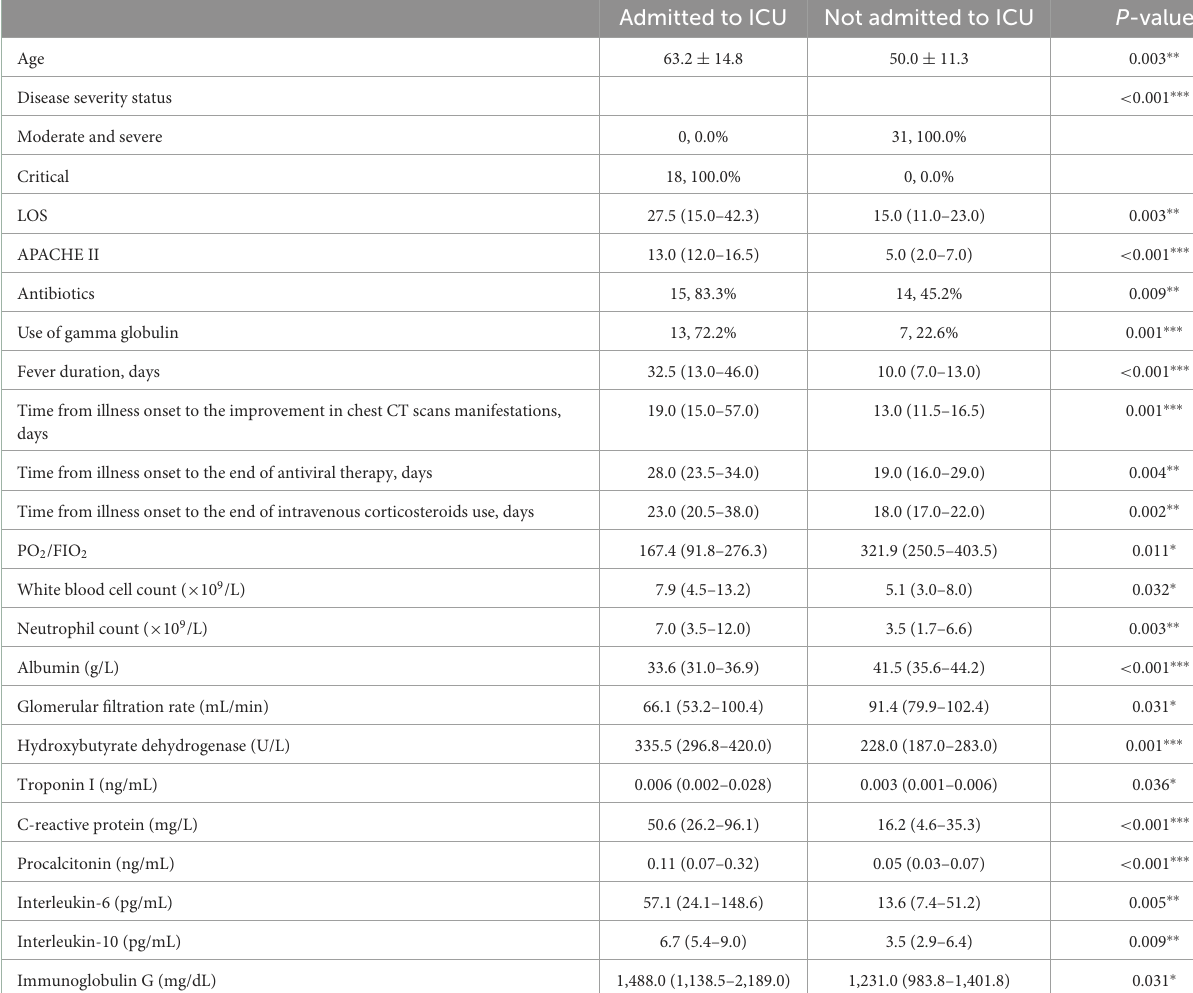
TABLE 5 Difference in sporadic cases admitted or not admitted to